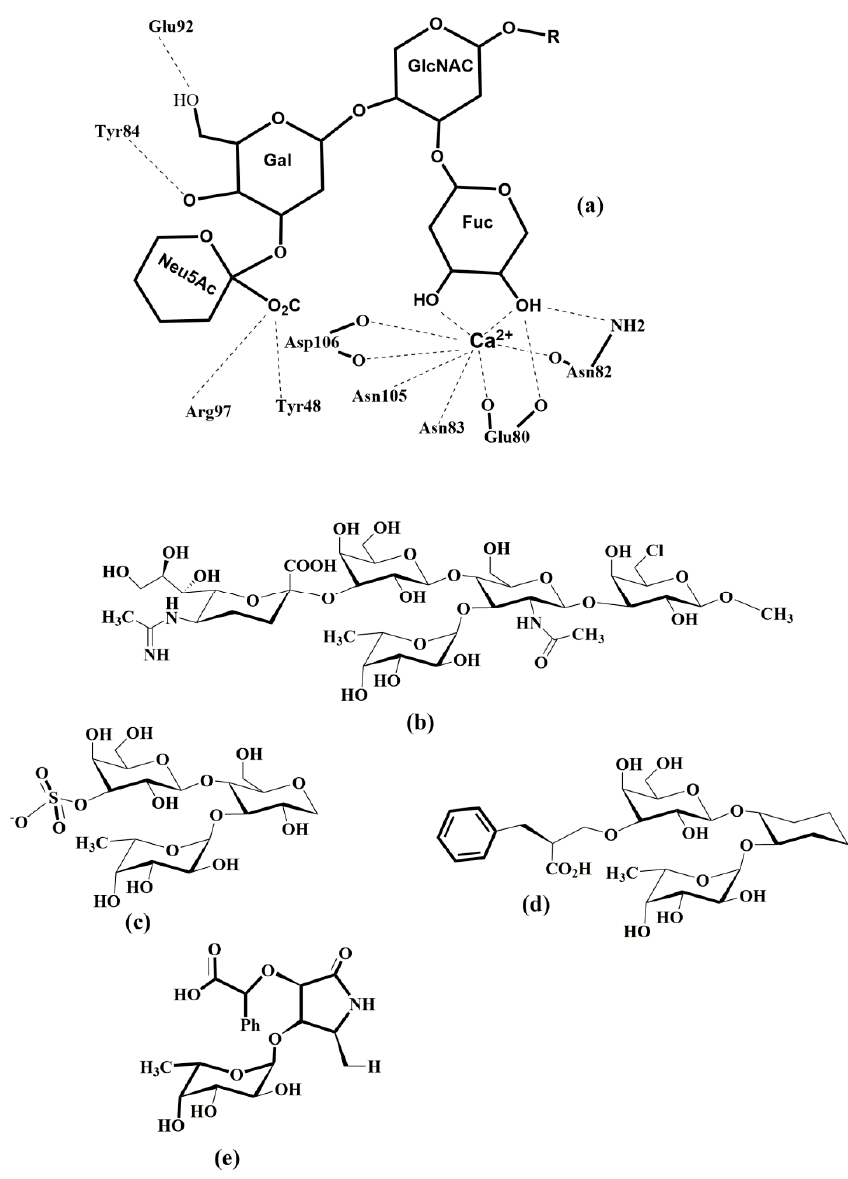
Figure 12. Schematic representation of ( a ) binding interactions of sLe x with E-selectin, ( b ) the selectin antagonist Cylexin [326], and selected glycomimetics containing ( c ) three sugars [327], ( d ) two sugars [328], and ( e ) one sugar [329].